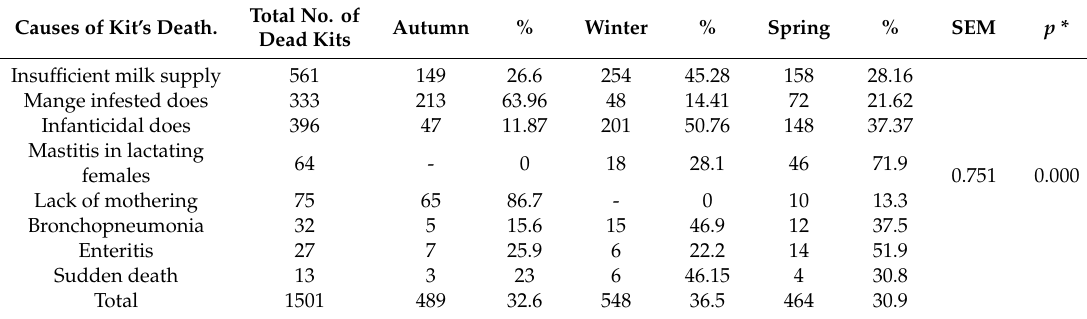
Table 2. Seasonal prevalence of preweaning mortality.